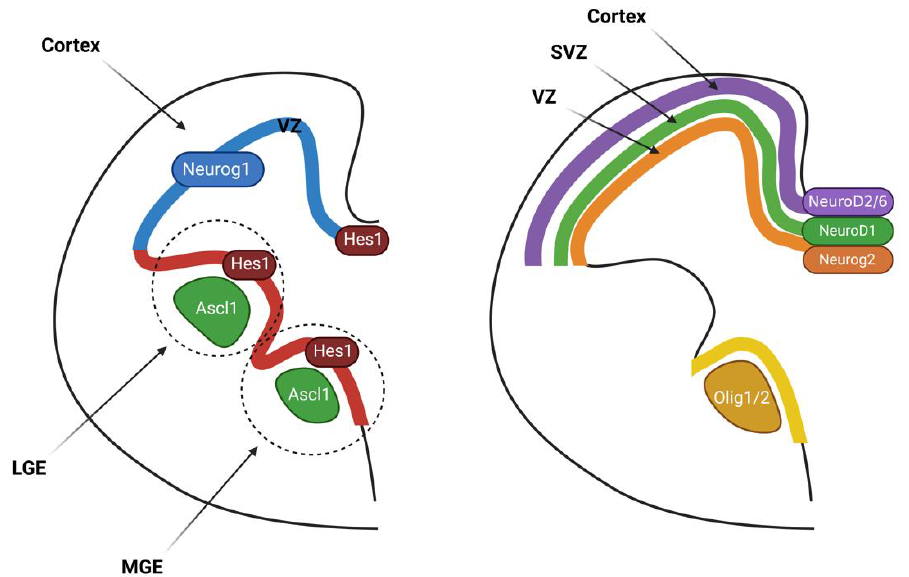
Figure 2. The rodent ventral and dorsal telencephalon. The left side of the figure is the rodent ventral telencephalon. The right side of the figure is the rodent dorsal telencephalon. In the ventral telencephalon, the Ascl1 gene (LGE, MGE) is expressed. Glial progenitors and oligodendrocyte precursor cells (OPCs) induce the expression of Olig1/2 . In the dorsal telencephalon, the cortical progenitors induce the development of the neocortex and the expression of Neurog1 and Neurog2 (VZ). The mature neurons induce the expression of NeuroD genes, such as NeuroD1 (SVZ), NeuroD2 , and NeuroD6 (cortex).